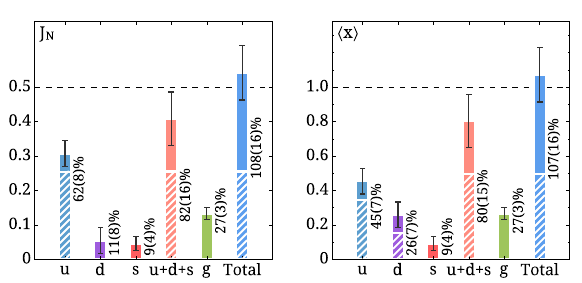
Figure 5. Nucleon spin (left) and momentum fraction (right) de- compositions from Ref. [6] in terms of the contributions from each quark flavor and from gluons. Striped segments refer to va- lence quark contributions, while solid segments show sea quark and gluon contributions.